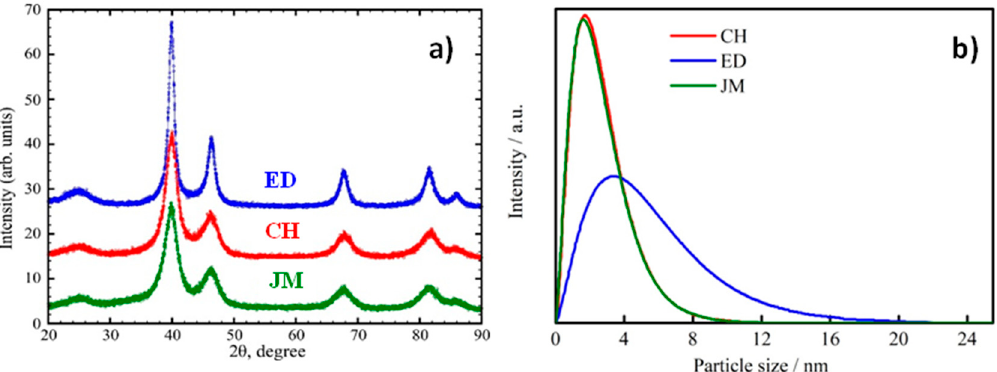
Figure 1. ( a ) XRD powder patterns of the Pt / C catalysts; ( b ) Particle size distribution of catalysts. The blue line refers to the catalyst prepared by the electrochemical dispersion pulsed alternating current technique (ED), the green curve is associated with commercial catalyst (JM), and the red curve is from the catalyst obtained by the polyol process (CH). Table 2. XRD data of the Pt/C catalysts.